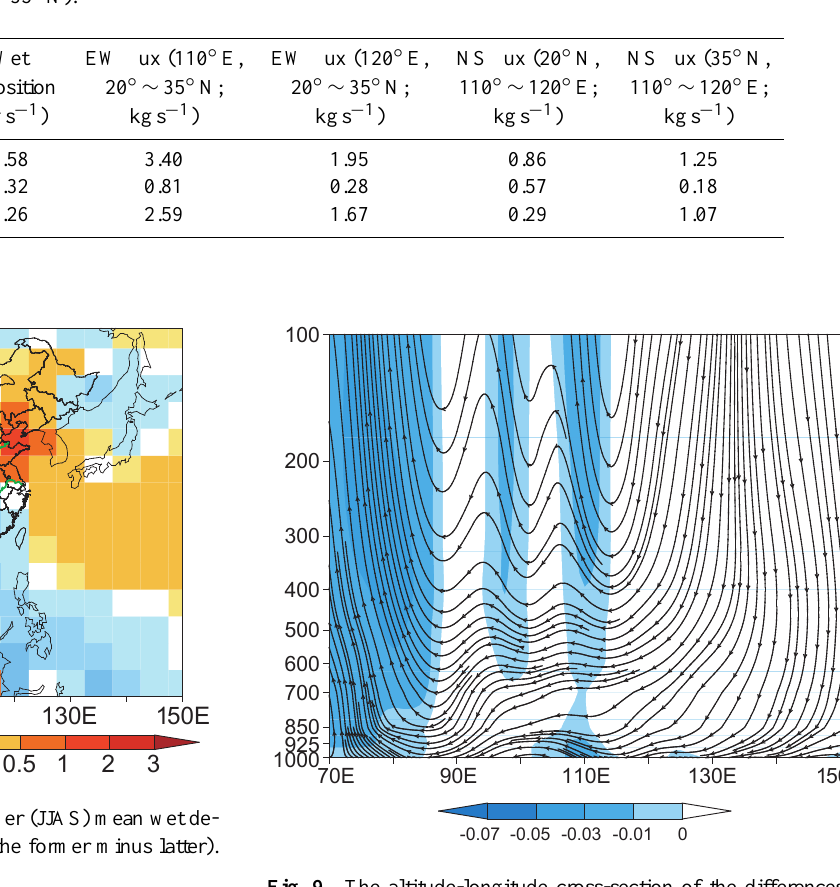
Fig. 9. The altitude-longitude cross-section of the differences in summer (JJAS) mean vertical circulation between 1998 and 2002 (the former minus latter). Values are averaged over latitude range of 10 ◦ –20 ◦ N. Color Shades denote the upward movement. Meteo- rological fields are from the GEOS-4 assimilated